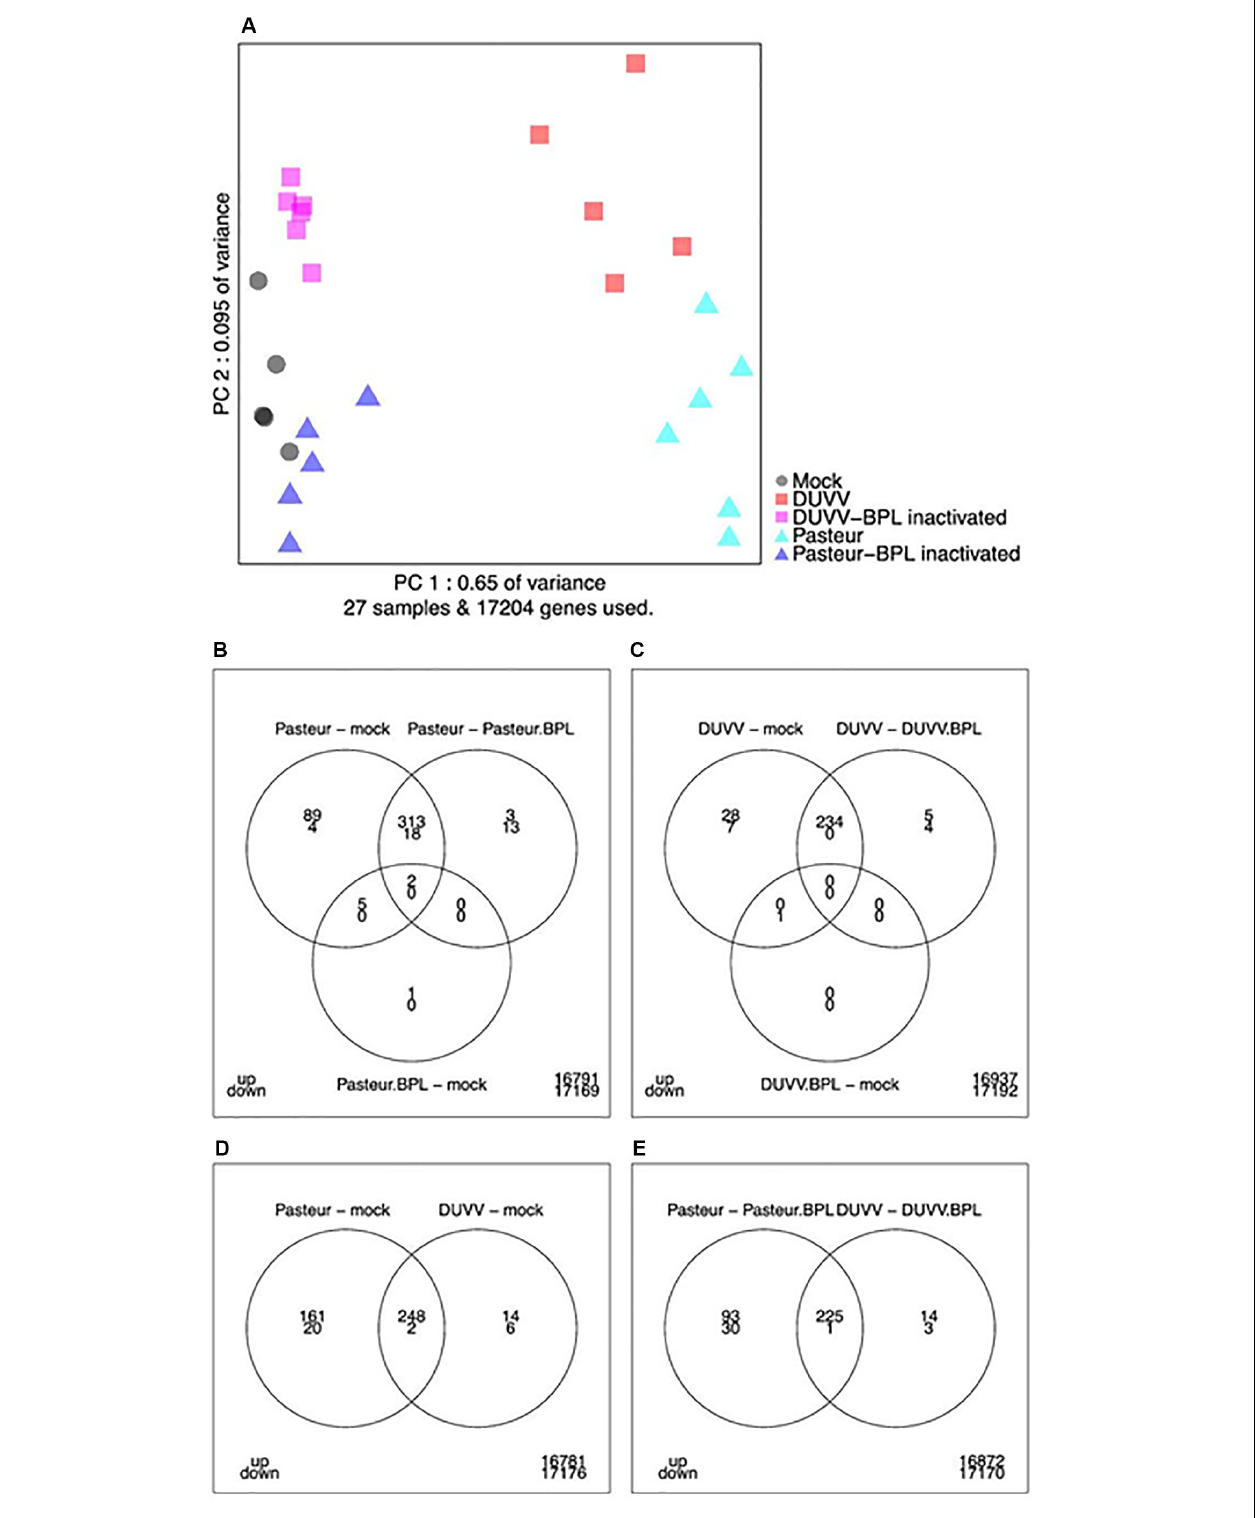
FIGURE 2 | (A) Principal component analysis of transcriptome snapshots. The first and second components explain 65 and 9.5% of the variance. Different samples are indicated by colors. (B–E) Venn diagrams showing the number of up- and down-regulated genes applying a FDR threshold of 0.05 and fold change threshold of two (i.e., a 2-log-fold change of 1) for the indicated contrasts and overlaps.